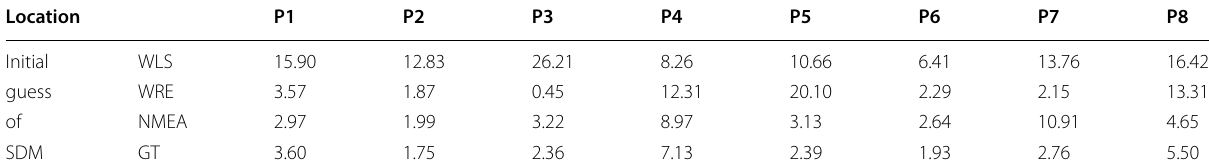
Table 10 The across error of real satellite visibility based shadow matching initialized by different approaches (m) Location P1 P2 P3